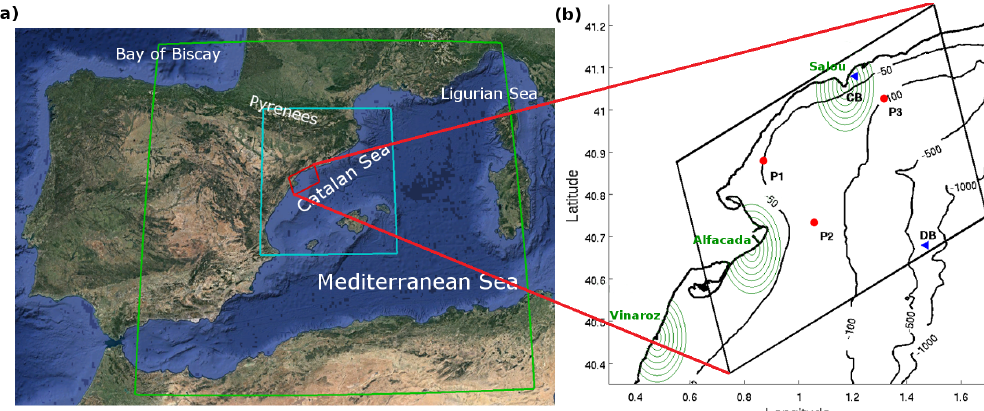
Figure 1. ( a ) Geographical location of the Ebro Delta in the NW Mediterranean Sea. Green, blue and red boxes show the three nested numerical domains used in this study. ( b ) Local domain at the Ebro Delta with the HF radar range arcs (in green), the buoy locations (blue triangles) and the location of three points used for analysis (in red: P1, P2 and